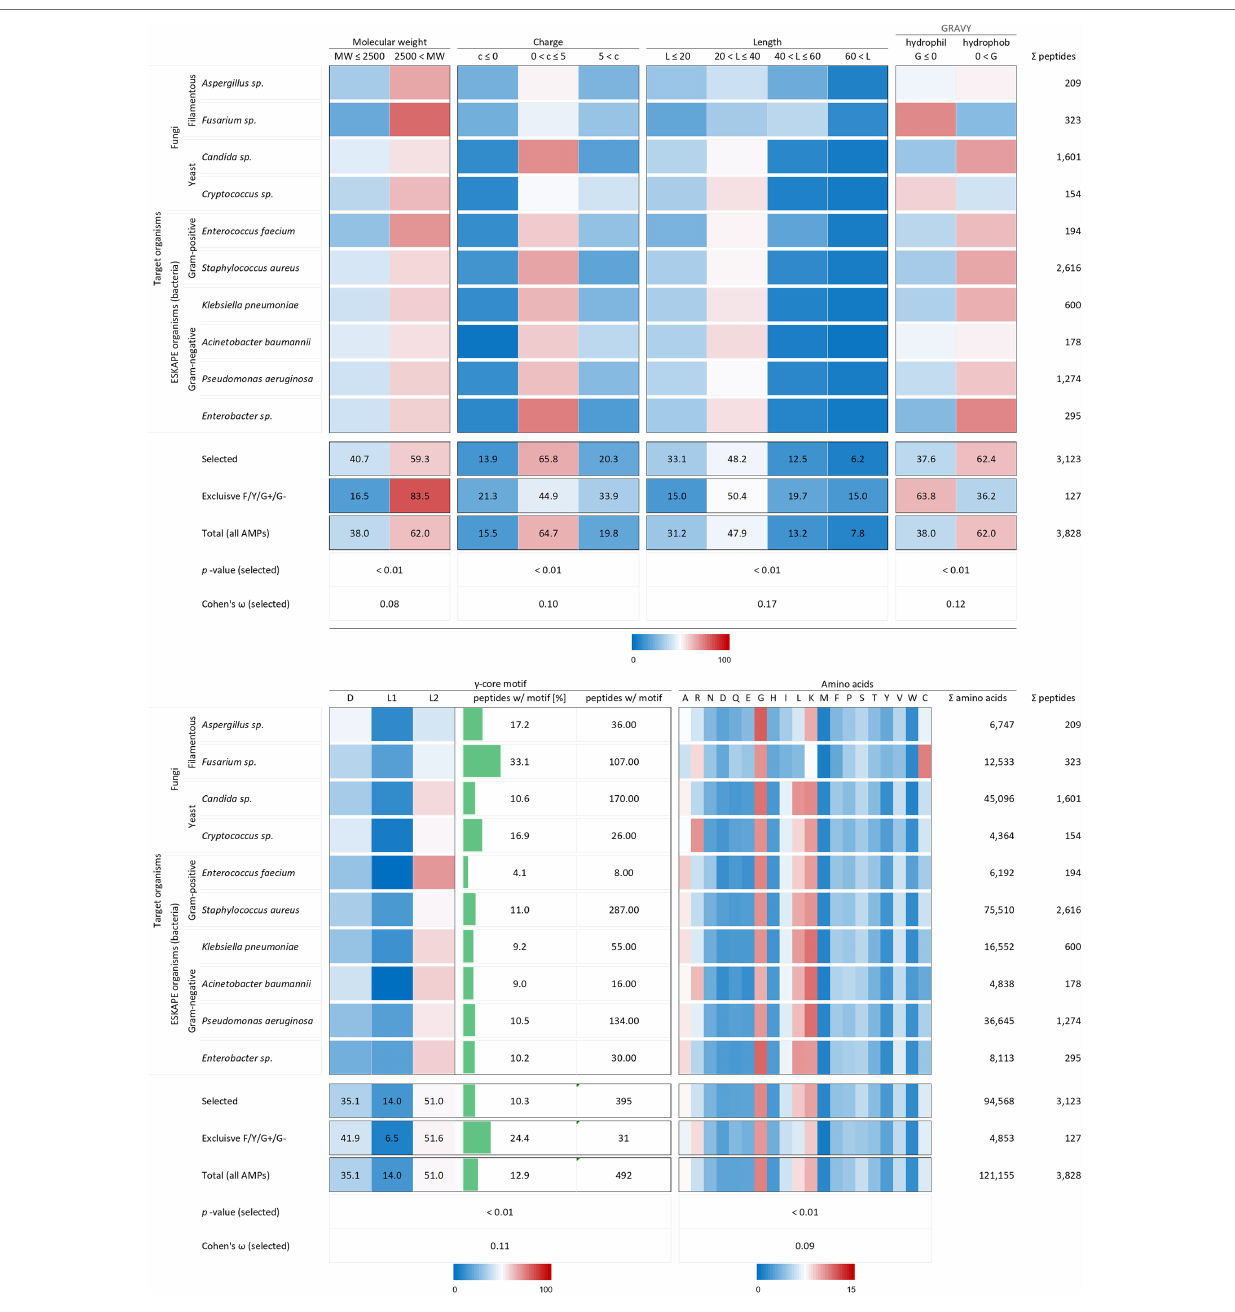
FIGURE 5 | Distribution of AMP properties in different target organism groups. Data were mined from the APD, DRAMP and DBAASP databases and subsequently processed. Percentage values were used to generate heat maps. The row ‘Total’ describes the summary of the data of the target organism rows. The values in the row named ‘Exclusive F/Y/G+/G-’ summarise the properties from AMPs, which encompass in parallel activities against filamentous fungi (F), yeast (Y), Gram-positive (G+) and Gram-negative (G-) bacteria. The row ‘Total (all AMPs)’ displays the results when all AMPs are considered (for comparison, see Figure 2 ). The association and its magnitude were determined by the p -value and the Cohen’s ω ,